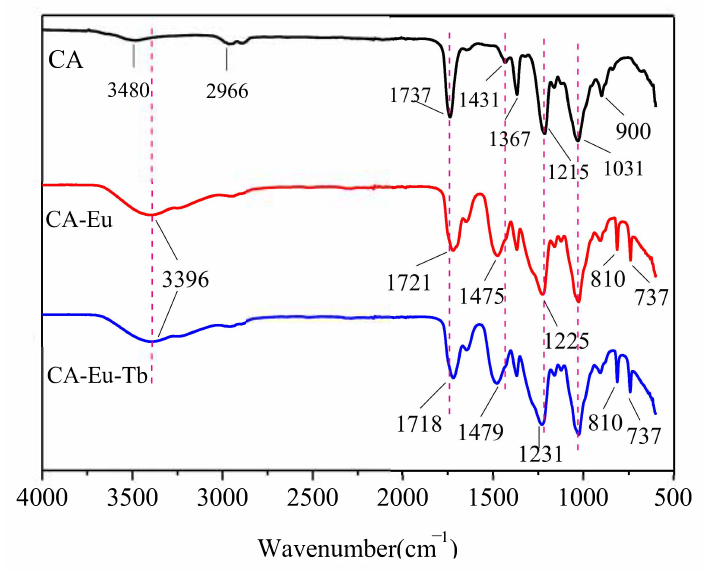
Figure 1. FT-IR spectra pure CA, CA-Eu (2:1), and CA-Eu-Tb (Eu: Tb = 1:1)